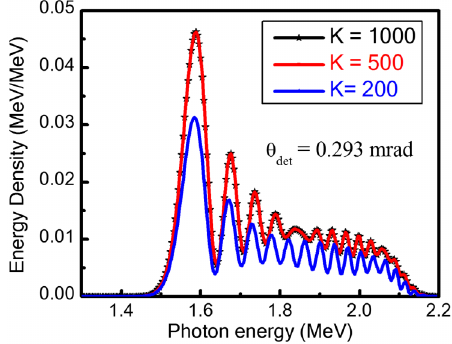
FIG. 7. Radiated energy density from the scattering of a 300-MeV electron by a 90-fs FWHM and 1 : 6 (cid:3) 10 18 - W = cm 2 - peak-intensity transform-limited pulse integrated over a detector subtending a cone of half angle (cid:4) det ¼ 0 : 293 mrad . The angle subtended by the detector was divided into 200 (blue line), 500 (red line), and 1000 (black line) differential angular bins. The spectral intensity at each angular bin was calculated and the radiation density was then integrated over the detector. Integrating the curve shown ( K ¼ 1000 ) and dividing the result by the peak photon energy ( (cid:2) 1 : 6 MeV ) gives 4 (cid:3) 10 (cid:4) 3 photons = electron collected by the detector ( (cid:4) det ¼ 0 : 293 mrad